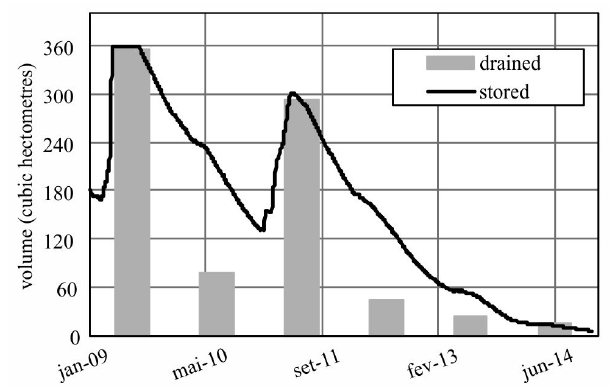
Figure 3. Inflow (annual drained volume) and stored volume of the Pentecoste reservoir from 2009 to 2014.